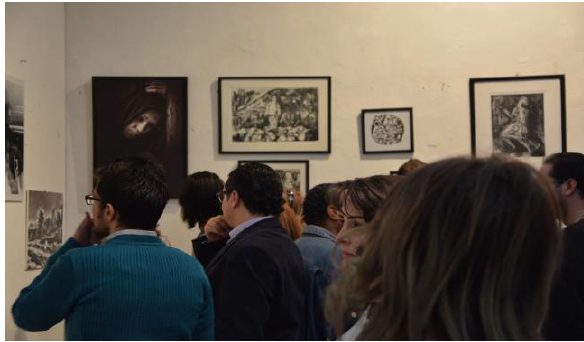
Figure 15. Exhibition Mars 2016, Mustafa Ali Gallery Archive.